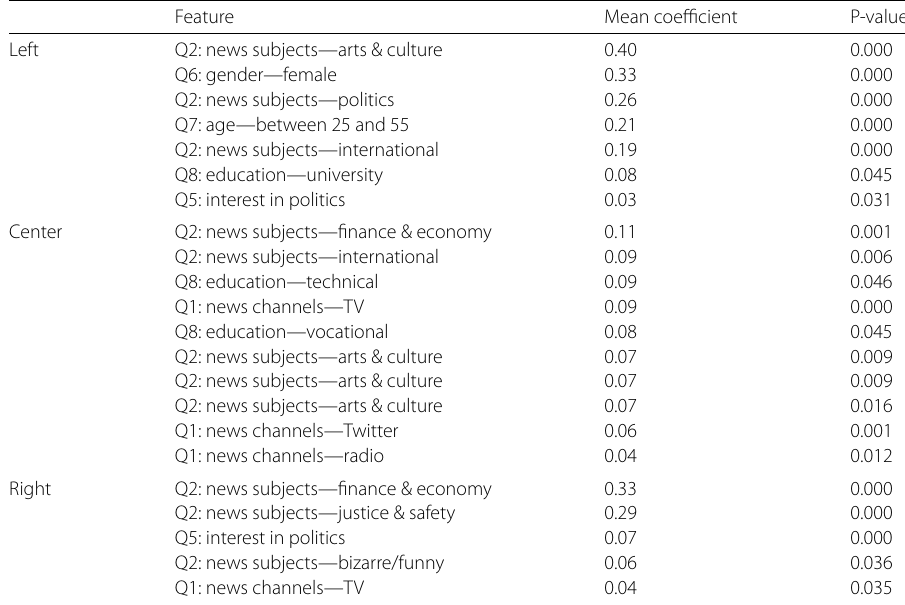
Table 11 The significant questions to political leaning for the survey (M3) Feature Mean coefficient P-value Left Q2: news subjects—arts & culture